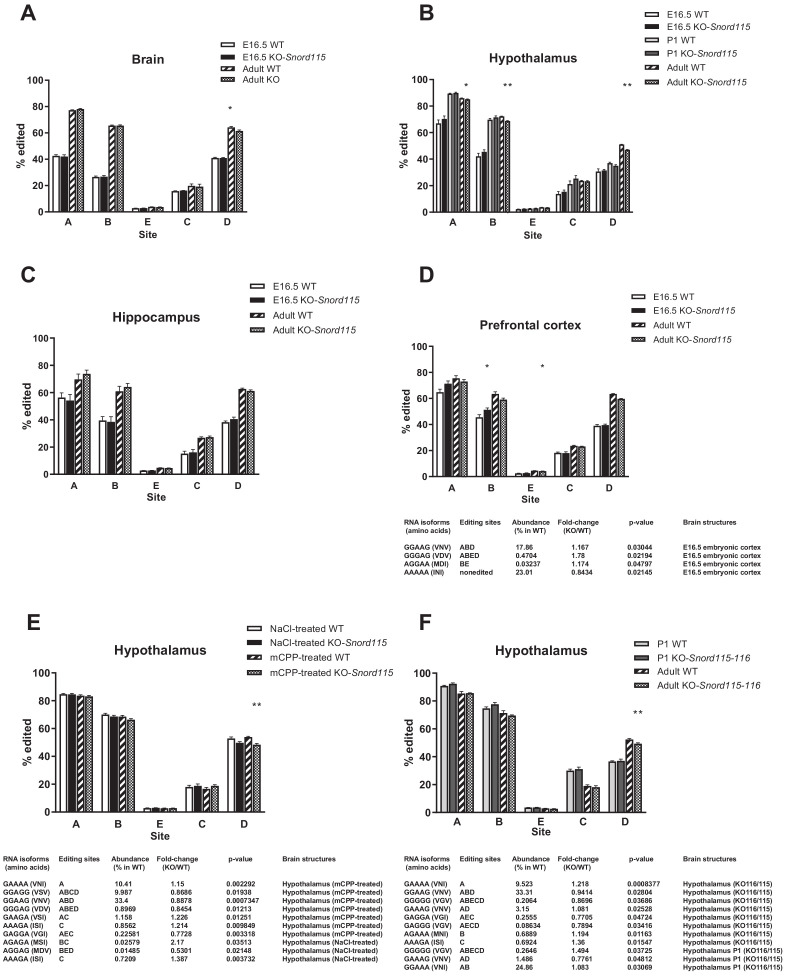
Loss of Snord115 and/or Snord116 has a mild impact on Htr2c RNA editing during development or after chronic mCPP treatment.(A-D) Loss of Snord115 has a weak impact on Htr2c RNA editing profiles in developing (E16.5 or P1) brain. (A) Histograms show the percentage of RNA editing at each individual site in the developing brain (A), hypothalamus (B), hippocampus (C) and prefrontal cortex (D) of Snord115-deficient embryos and their WT littermates. Histograms showing RNA editing in the adult (see also Figure 3) are also shown for comparison. A four-way ANOVA shows that RNA editing rates increase during development (p<2 × 10−16), it depends on the brain area (p<2 × 10−16) and the editing site being considered (p<2 × 10−16), but there is no significant effect of genotype (WT vs. KO; p=0.3671). (E) Loss of Snord115 has a weak impact on Htr2c RNA editing in the adult hypothalamus after chronic mCPP treatment. Histograms show the percentage of RNA editing at each individual site in the hypothalamus of adult Snord115-deficient mice and WT littermates treated with mCPP or saline (0.9% NaCl) solutions (twice a day for 5 consecutive days; i.p. 5 mg/kg; n = 7–5 per genotype). Note that changes in RNA editing isoforms in control mice treated with saline solution differs from those observed with home-cage mice (Figure 3). (F) The simultaneous loss of Snord115 and Snord116 has a weak impact on Htr2c RNA editing in P1 and adult hypothalamus. Histograms show the percentage of RNA editing at each individual site in adult and P1 hypothalamus of Snord115-116-deficient mice and their WT littermates (n = 6–8 per genotype). D-F: The tables list significant changes in the proportion of Htr2c edited isoforms. The relative abundance of these differentially expressed Htr2c spliced isoforms, as measured in WT, is indicated (%). A-F: Statistically significant differences between WT and SNORD-KO mice are indicated as *p<0.05 and **p<0.01.